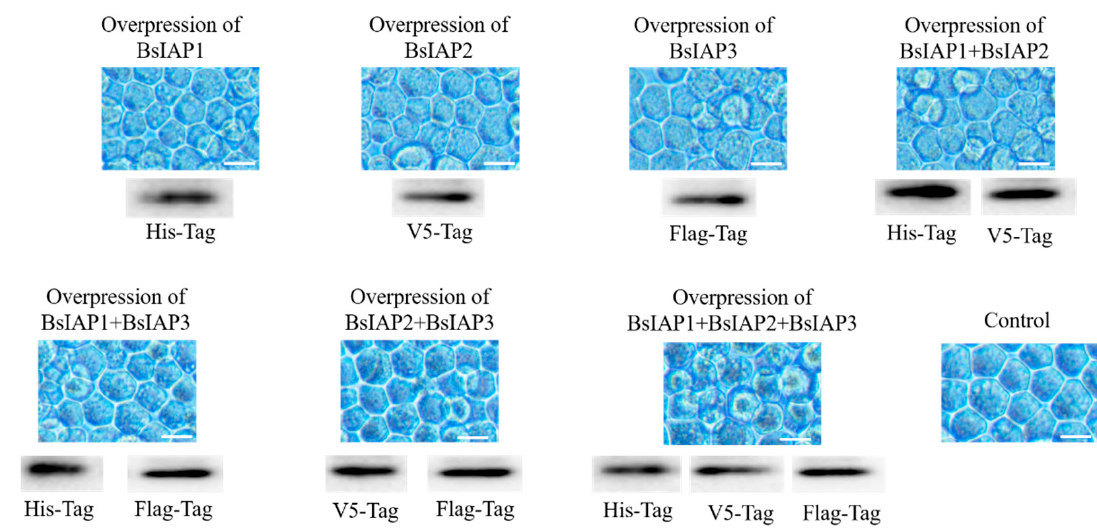
Figure 4. Transfection of insect Sf9 cells and identification of BsIAPs by western blot. The cells of the control group were cultured for the same time after transfection with pIE vector. After the transient expression plasmids were transfected into Sf9 cells (48 h, Bar = 25 µ m), the intracellular BsIAPs were identified by western blot with three anti-tag antibodies (His, V5, and Flag), respectively. Western blot identification showed that different BsIAPs (and their combinations) were highly expressed in insect Sf9 cells after co-transfection (see the Figure S1 for details)